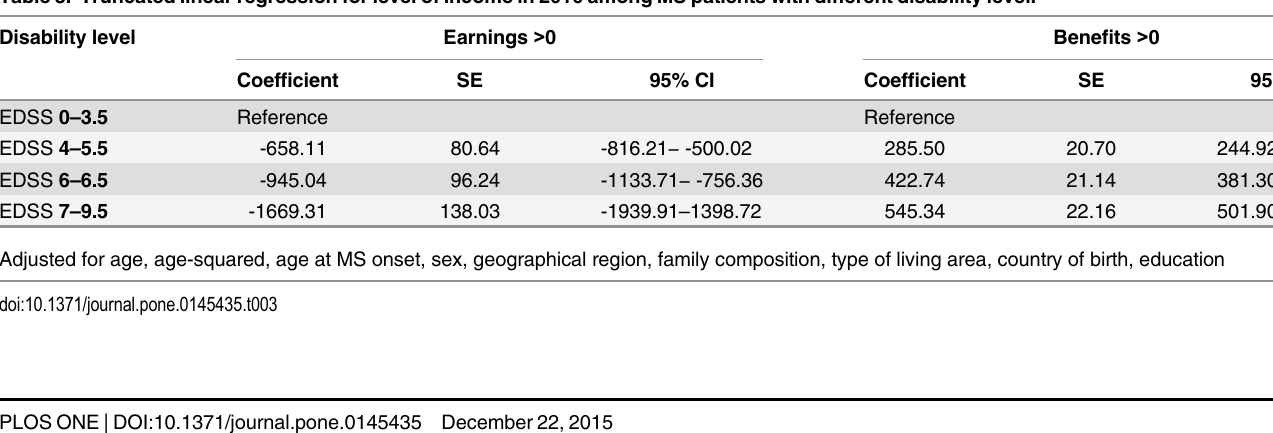
Table 3. Truncated linear regression for level of income in 2010 among MS patients with different disability